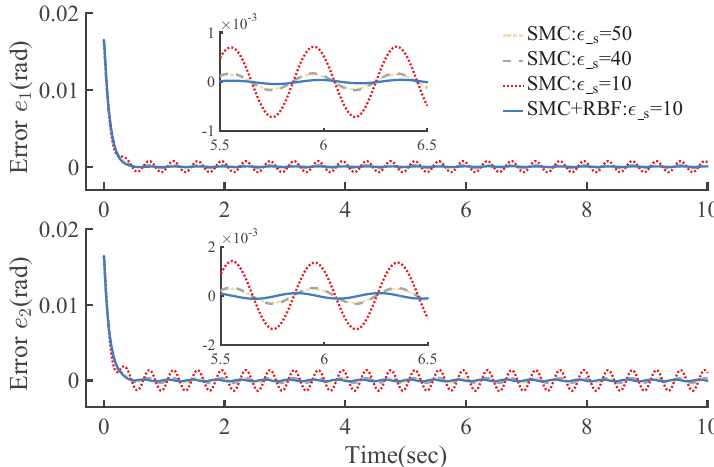
Figure 4. Trajectory tracking error e .